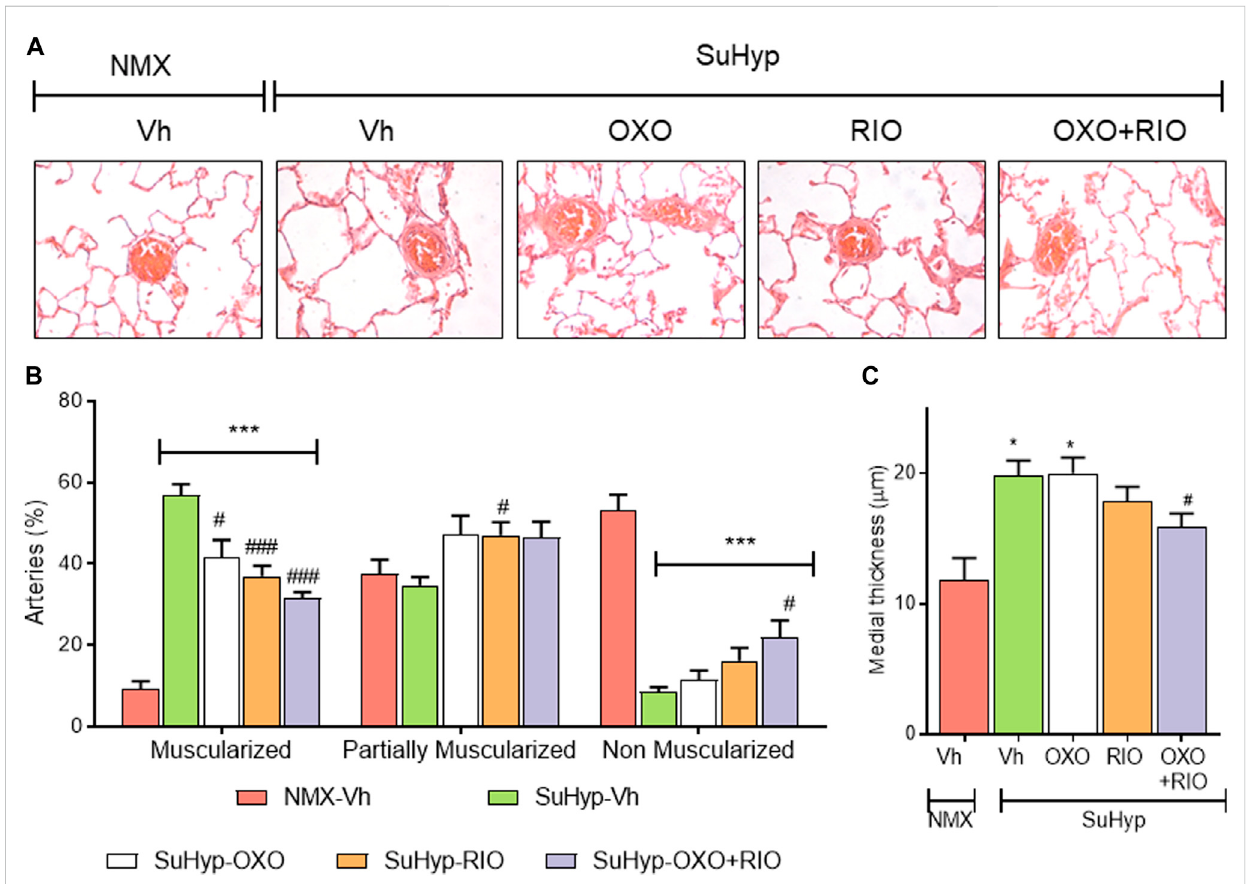
FIGURE 4 Riociguat and 5-z-7oxozeaenol exert additiveeffects on preventing pulmonary vascular remodeling. (A) Percentage ofmuscular, partially muscular and non-muscular arteries in the different treatment groups. (B) Medial wall thickness of pulmonary arteries (50 – 200 μ m external diameter). (C) Representative images of lung histology. Each bar shows the mean +SEM ( n = 5-6 animals in each group). * p < 0.05 versus normoxia + vehicle and # p < 0.05 versus hypoxia + vehicle (One-way ANOVA followed by Bonferroni ’ s post hoc